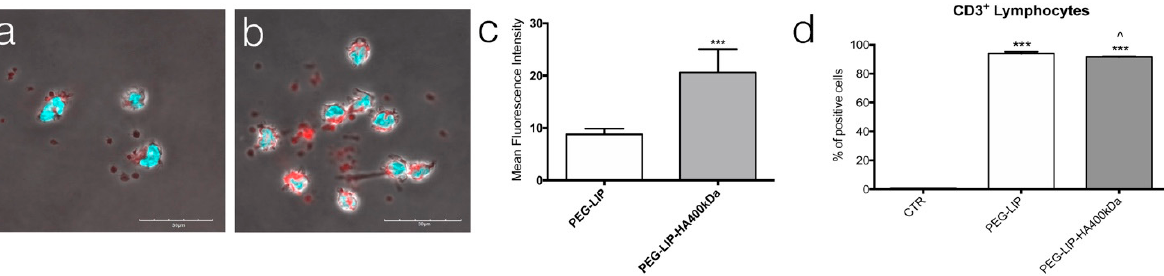
Figure 8. Assessment of liposomes internalization in AM and CD3 + lymphocytes derived from CLAD patients. ( a – c ) Confocal microscopy analysis of Rhodamine-labeled ( a ) PEG-LIP and ( c ) PEG-LIP-HA400kDa internalized by AM after 1 h of incubation (liposomes = red signal; DAPI = light blue), with ( b ) quantification of mean fluorescence intensity of red signal present in three different ROI in ( a ) and ( c ). Data are represented as mean ± SD, ***, p < 0.001 vs. PEG-LIP. ( d ) Quantification of the interaction of Rhodamine-labeled PEG-LIP and PEG-LIP-HA400kDa with CD3 + lymphocytes after 1 h of incubation and analyzed by flow cytometry. Data are represented as mean ± SD. ***, p < 0.001 vs. CTR. Scale bar = 30 µ m. ˆ, p < 0.05 vs.